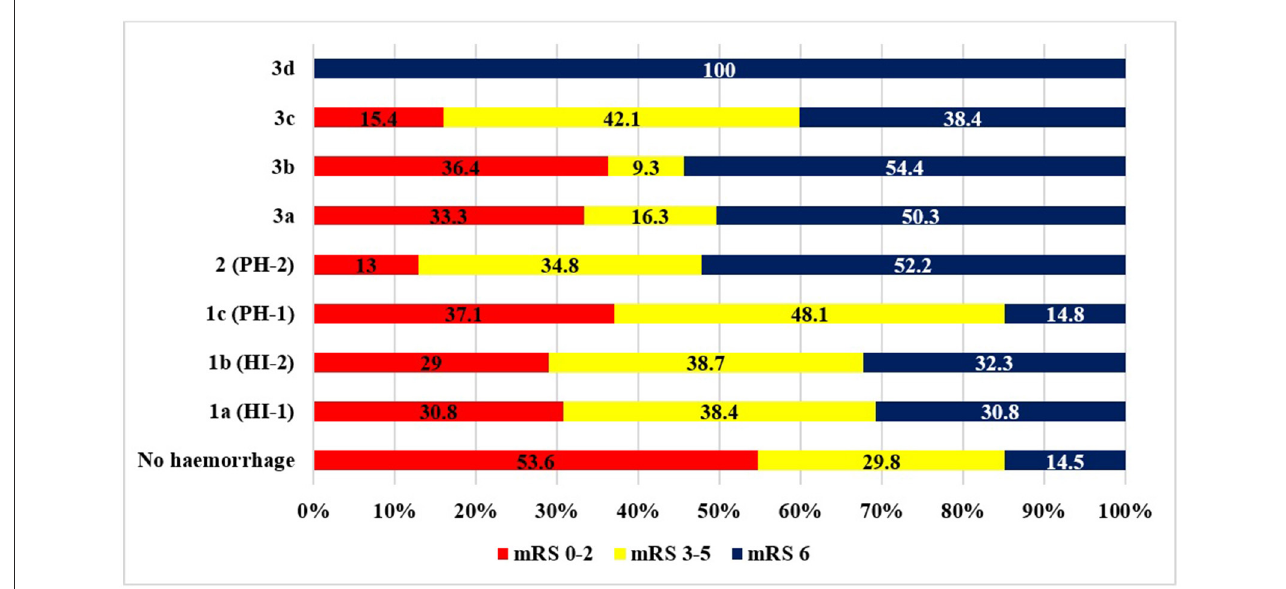
FIGURE5 Outcome at 3 months on the mRS by hemorrhage type. Abbreviations are defined in the text.